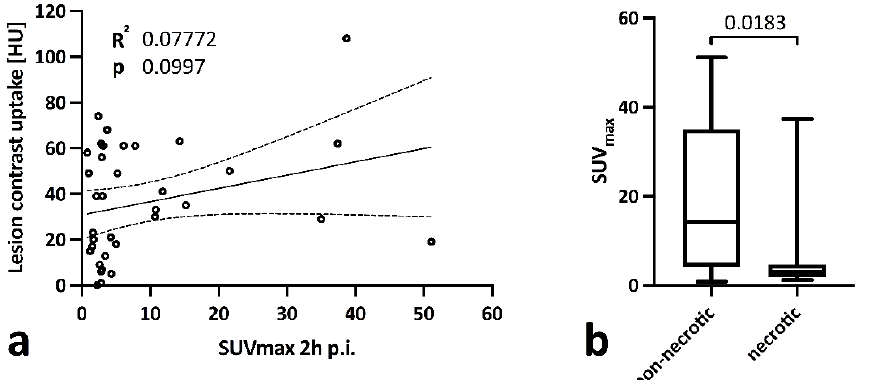
Figure 2. Linear correlation analysis between lesion SUV max (2 h p.i.) and CT contrast-enhancement in all lesions ( a ) and group comparison between lesions with non-necrotic and necrotic CT appearance via a Kruskal-Wallis test ( b ).